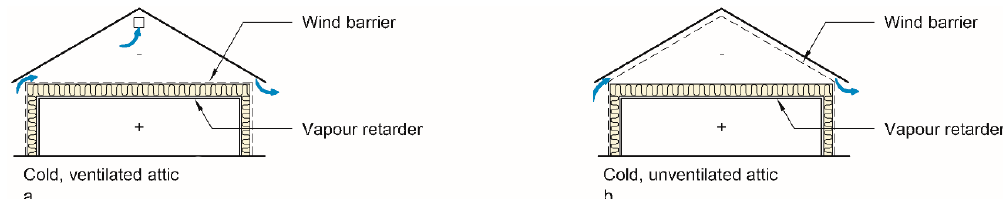
Figure 3. Roof Type C with cold attic. ( a ) Cold, ventilated attic space with air stream flowing through the attic itself. ( b ) Cold, unventilated attic space with all ventilation between the underlayer roof and the roof covering. Image further developed from [16].